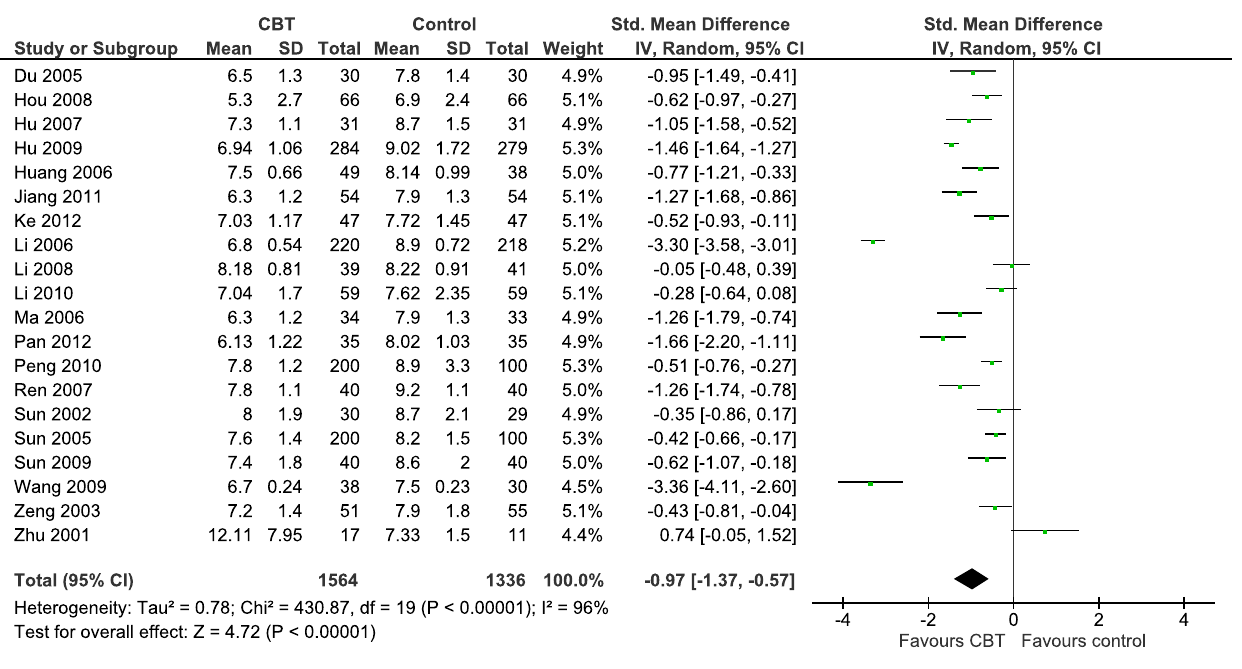
FiGURe 2 | Meta-analysis illustrating the standardized effects of cognitive behavioral therapy (CBT) vs. control for glycated hemoglobin